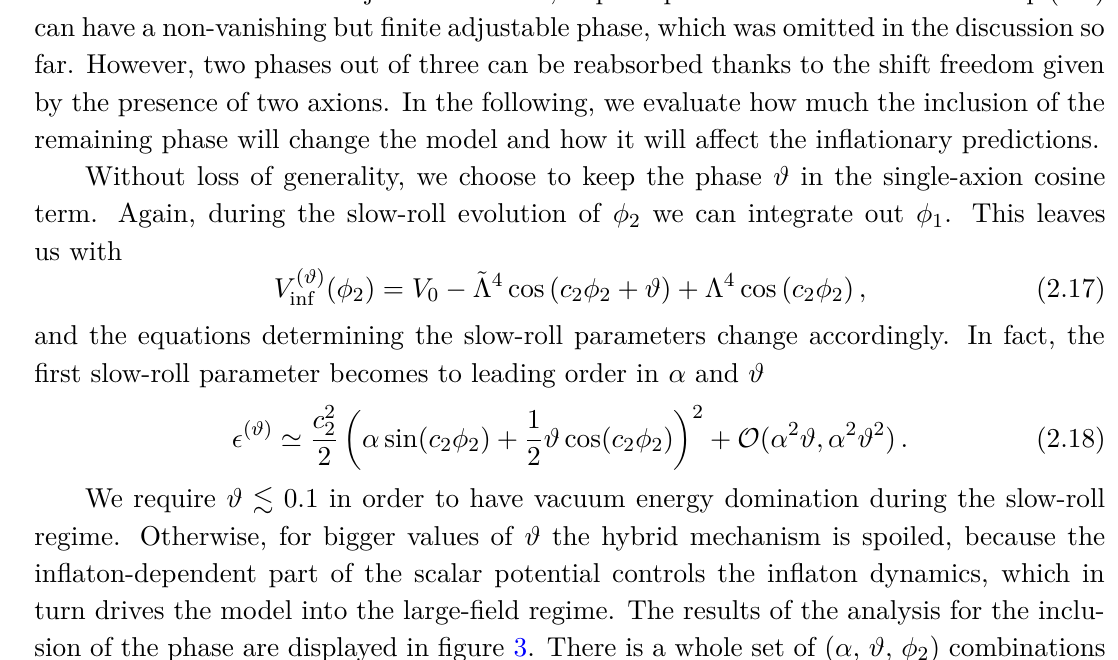
Figure 2 . We show the analytical predictions for n s and r varying log log ( α ) ∈ [ − 3 , − 2] (purple-to-white contour) together with the 1 σ and 2 σ confidence contours 10 found by Planck [2] (grey and mint contours, respectively), where they combined the Planck data the with BICEP2/Keck Array [3] and BAO [36–38]